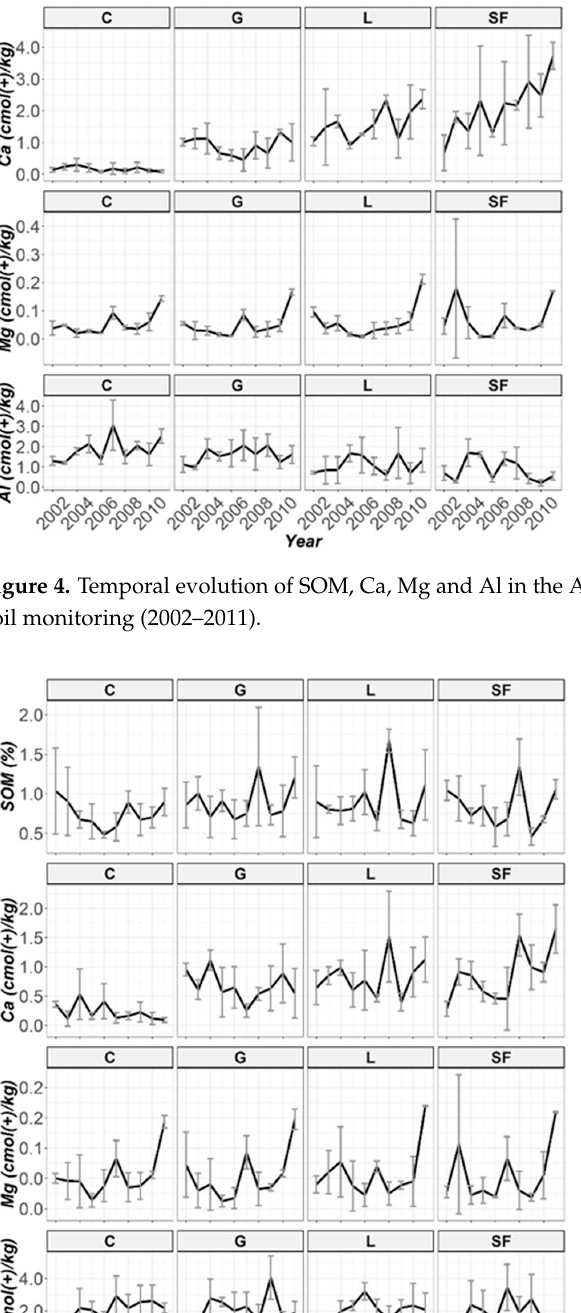
Figure 5. Temporal evolution of SOM, Ca, Mg and Al in the AB horizon throughout the ten years of soil monitoring (2002–2011).